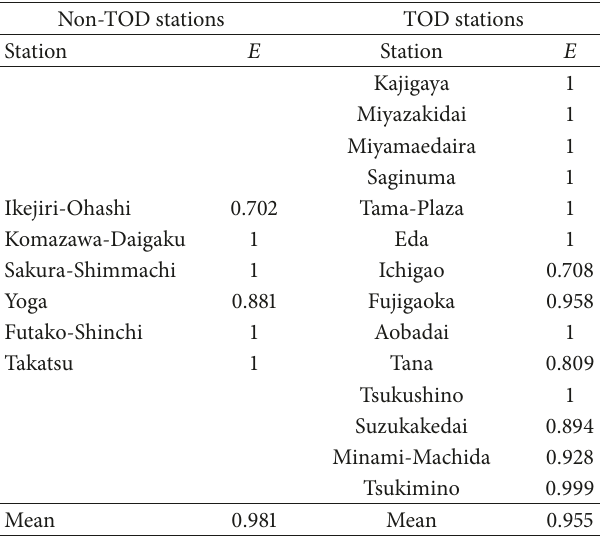
Table 5: Efficiencies of nontransfer stations considering operation year.